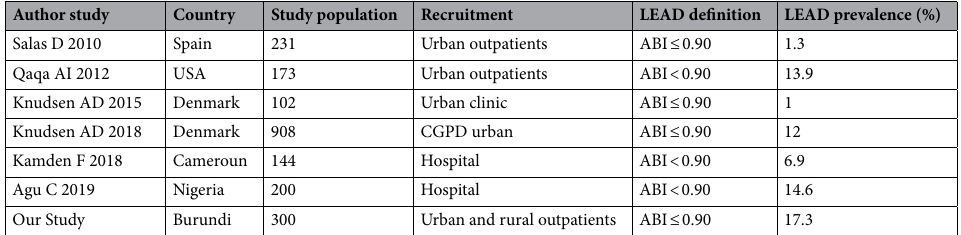
Table 4. Last decade cross-sectional studies on LEAD prevalence in HIV infected subjects. ABI ankle brachial index, CGPD Copenhagen general population study, LEAD lower extremity arterial